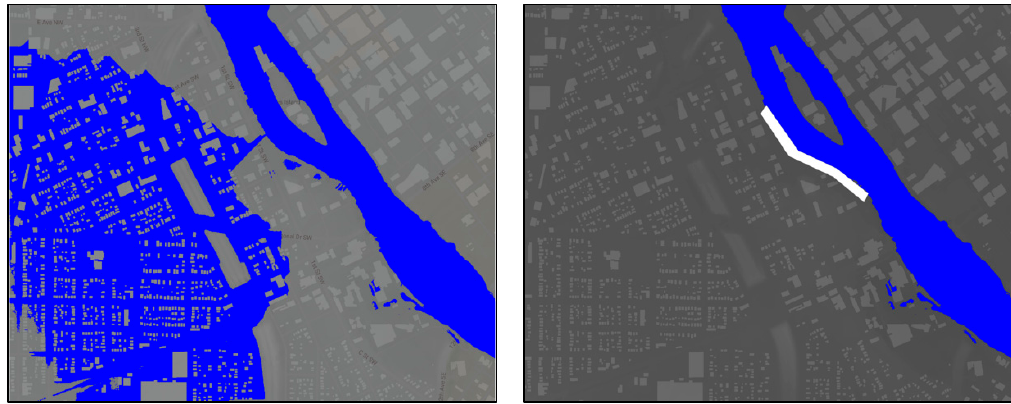
Figure 5. Maps generated for Cedar Rapids, Iowa before ( left ) and after ( right ) mitigation using levees.